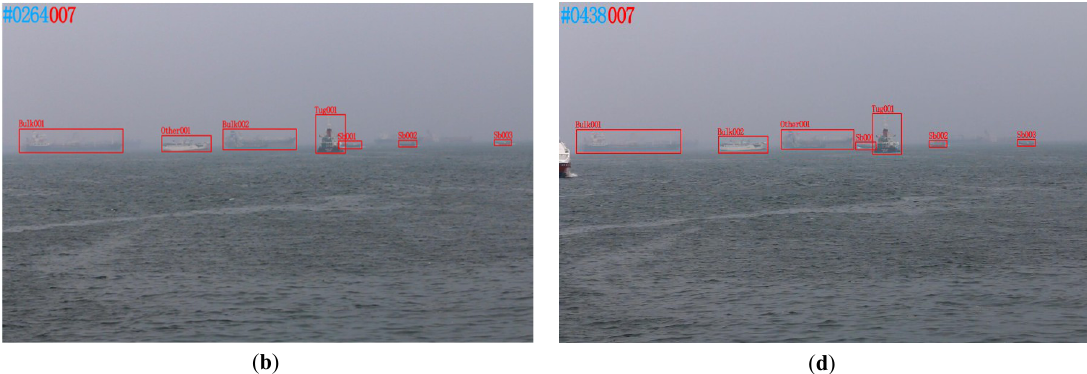
Figure 6. Visual tracking results of video sequence (MVI_1448_VIS_Haze) with occlusion. Six vessels have been stably tracked in frame #0126 (a). Starting in frame #0264 (b), Sb001 was occluded by Tug001 until being completely occluded in frame #0355 (c) and then reappeared in frame #0370 until it was completely visible in frame #0438 as shown in (d).